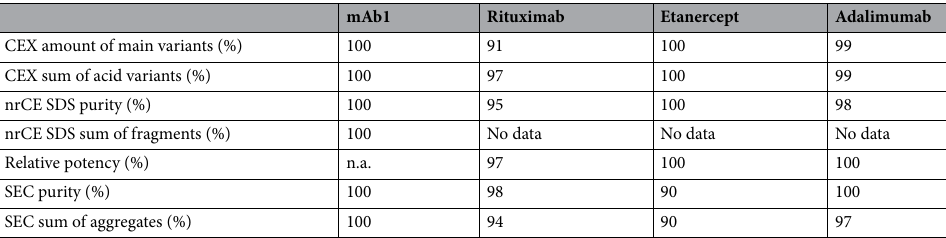
Table 1. Percent of batches where long-term experimental stability data are in agreement with long-term stability predictions. Percent of batches that meets the criteria is obtained as the ratio of experimental long- term data points between 6 and 36 months at 5 °C that fall within the prediction interval relative to the total number of all measured values during that time. Prediction intervals are determined from the 6 months accelerated stability data . Only batches passing the criterion goodness of model fit R 2 ≥ 0.9 are considered in the analysis. Numbers of passed batches are 8 (molecule in development mAb1), 36 (rituximab), 11 (etanercept) and 19 (adalimumab). “no data” indicates that no accelerated and long-term experimental stability studies were performed for that quality attribute and protein, “n.a.” indicates not applicable since not enough data have been collected.